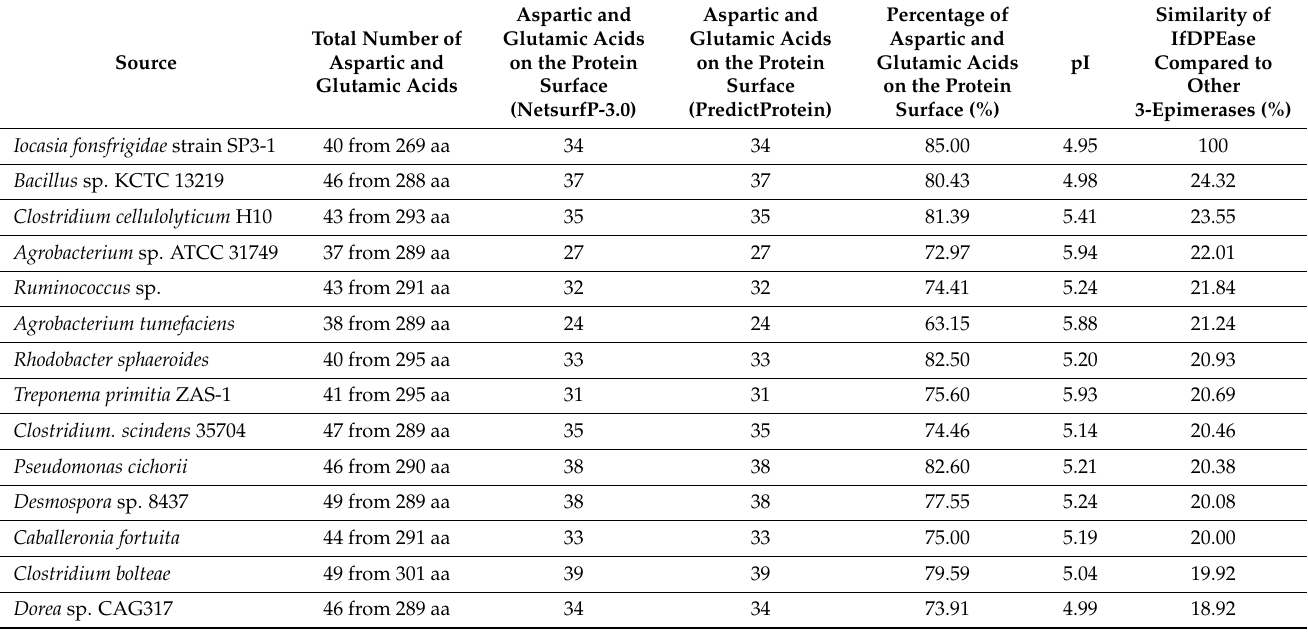
Table 1. Total number of acidic amino acids residues (aspartic and glutamic acids), acidic amino acid residues on protein surfaces, percentage of aspartic and glutamic acids on protein surfaces, pI values, and % similarity of IfDPEase compared to other ketose 3-epimerases from various microorganisms. The analysis of aspartic and glutamic acids on the protein surface was obtained from the NetsurfP- 3.0 https://dtu.biolib.com/NetSurfP-3/ (accessed on 18 October 2022) and the